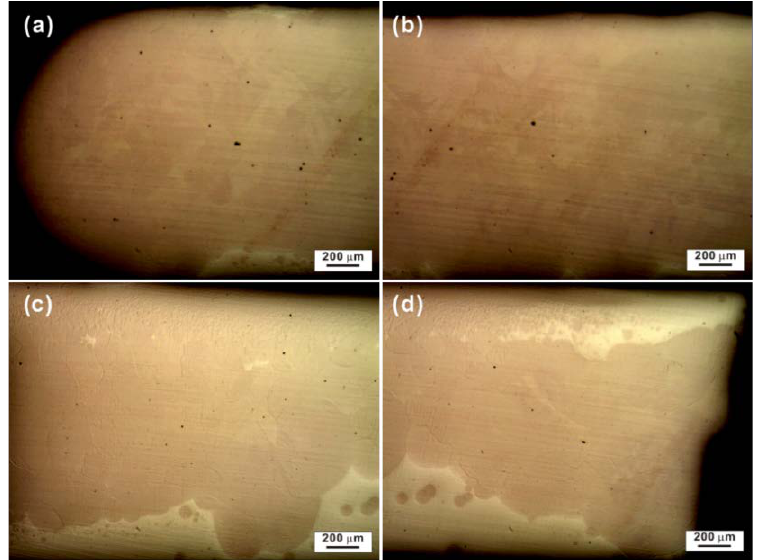
Figure 3. OM pictures of the longitudinal cross-sections cut from the top parts ( a , b ) to from the bottom parts ( c , d ) of the as-cast Cu 48.75 Zr 48.75 Zn 2.5 rod; The